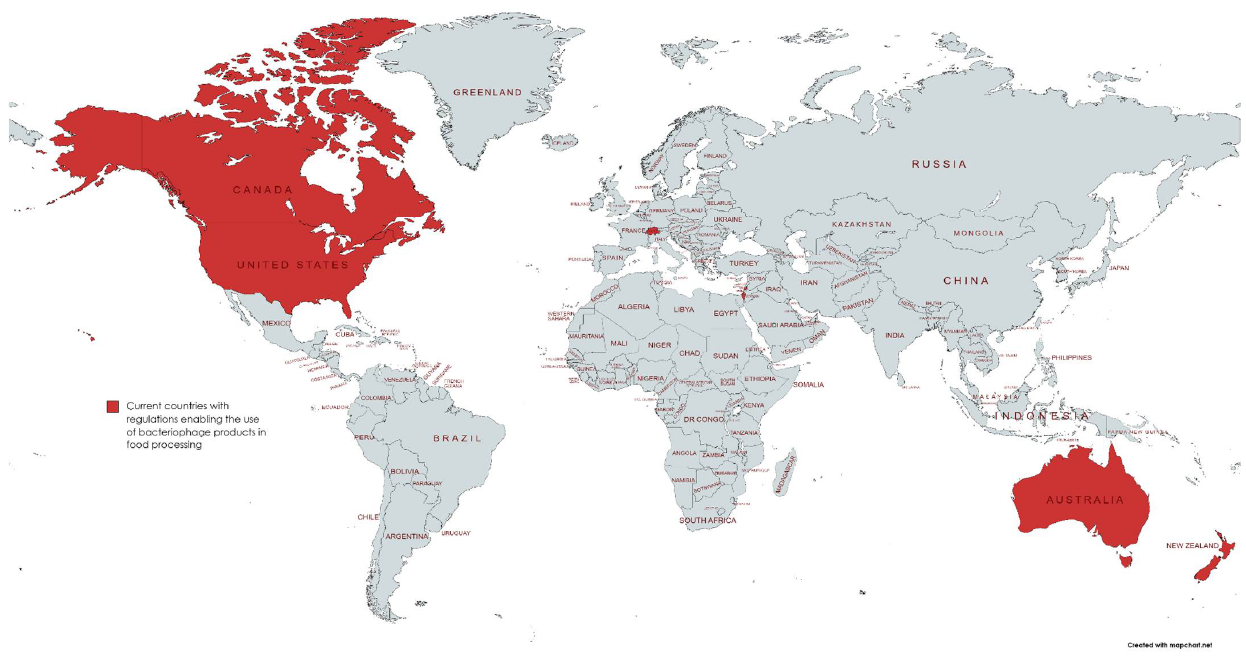
Figure 1. Map of current countries with regulations enabling the usage of phage products in food processing and food products. Countries include Canada, the USA, Switzerland, Israel, Australia, and New Zealand. and New